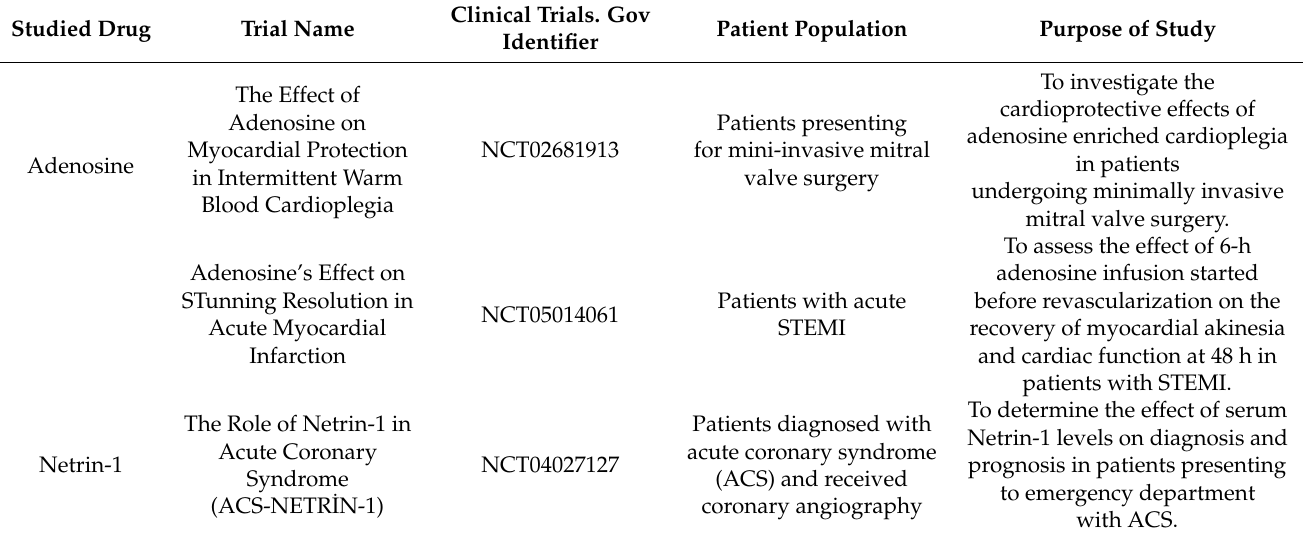
Table 2. Ongoing clinical trials targeting the Adenosine pathway for myocardial